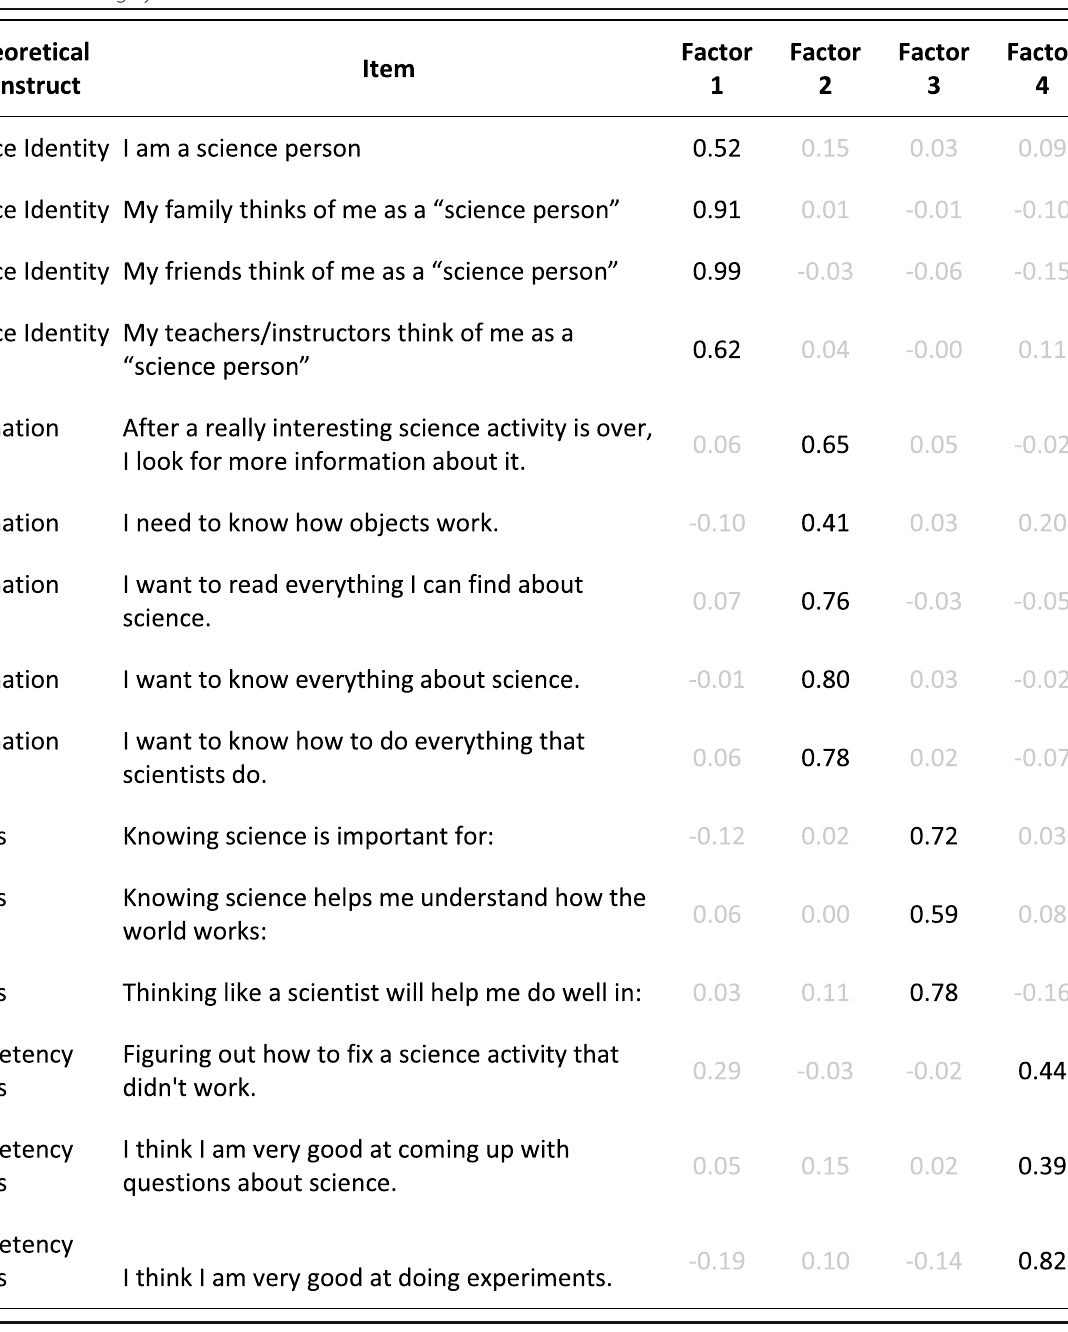
Table 3 Exploratory factor analysis loadings for science identity, fascination, values, and competency belief survey items. Loadings below 3 are shown in gray